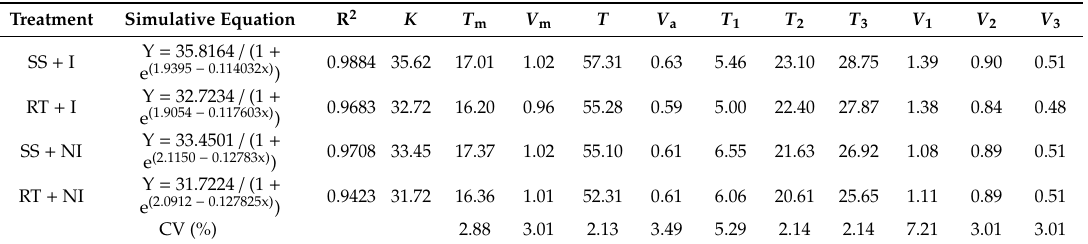
Table 7. Effects of different tillage methods on grain-filling characteristic parameters.